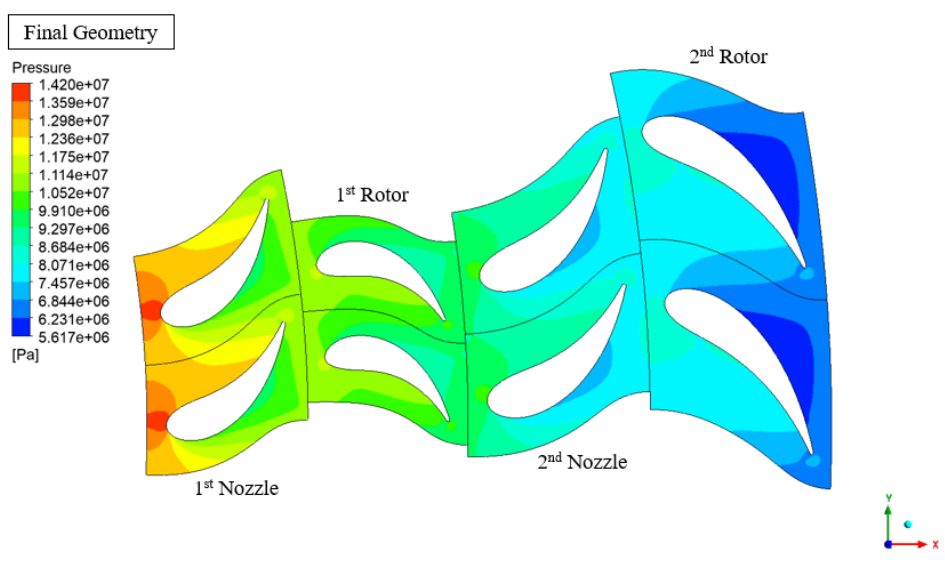
Figure 20. Pressure contour of the final geometry.